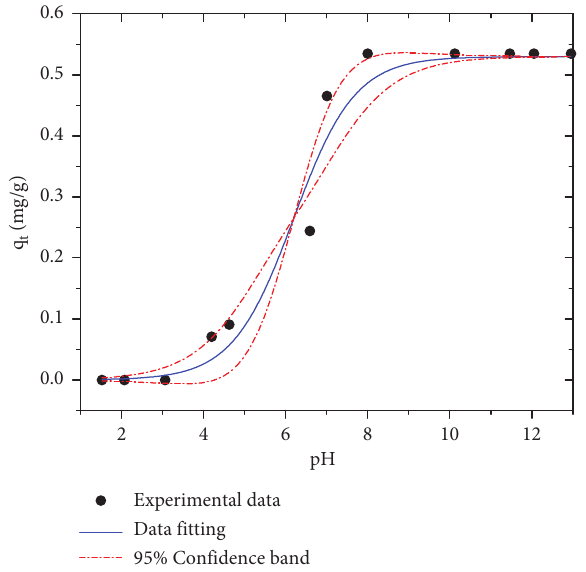
Figure 7: Variation of the sorption capacity with the pH and values estimated by means of the proposed